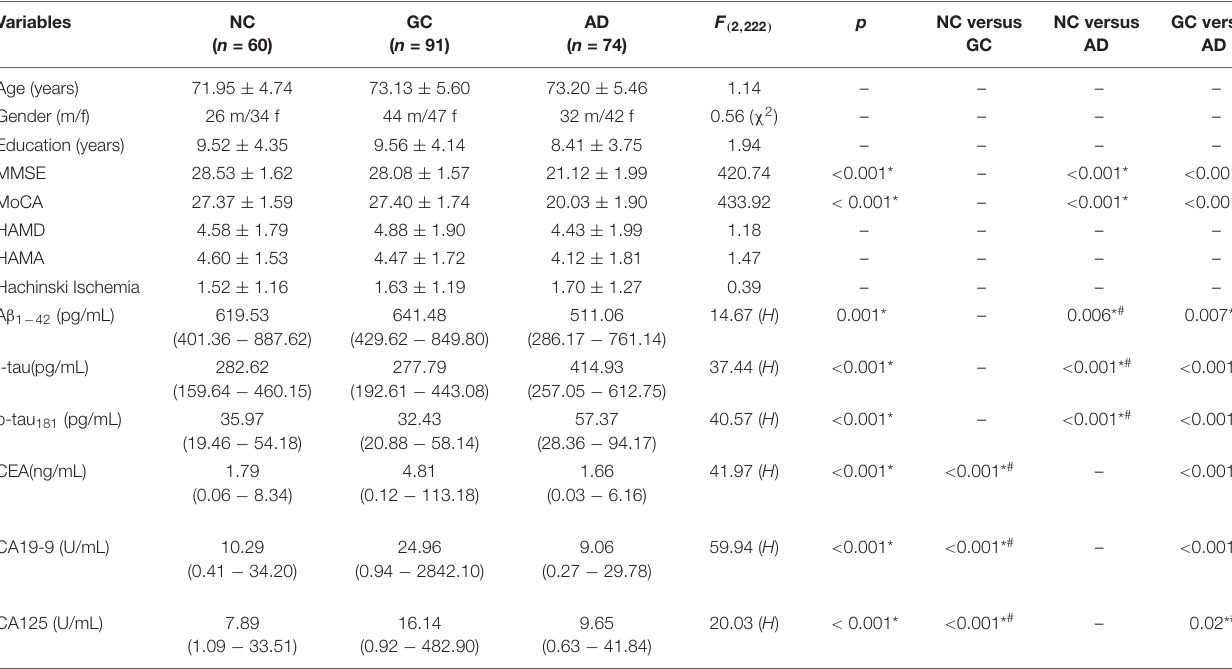
TABLE 1 | Subject demographics and clinical